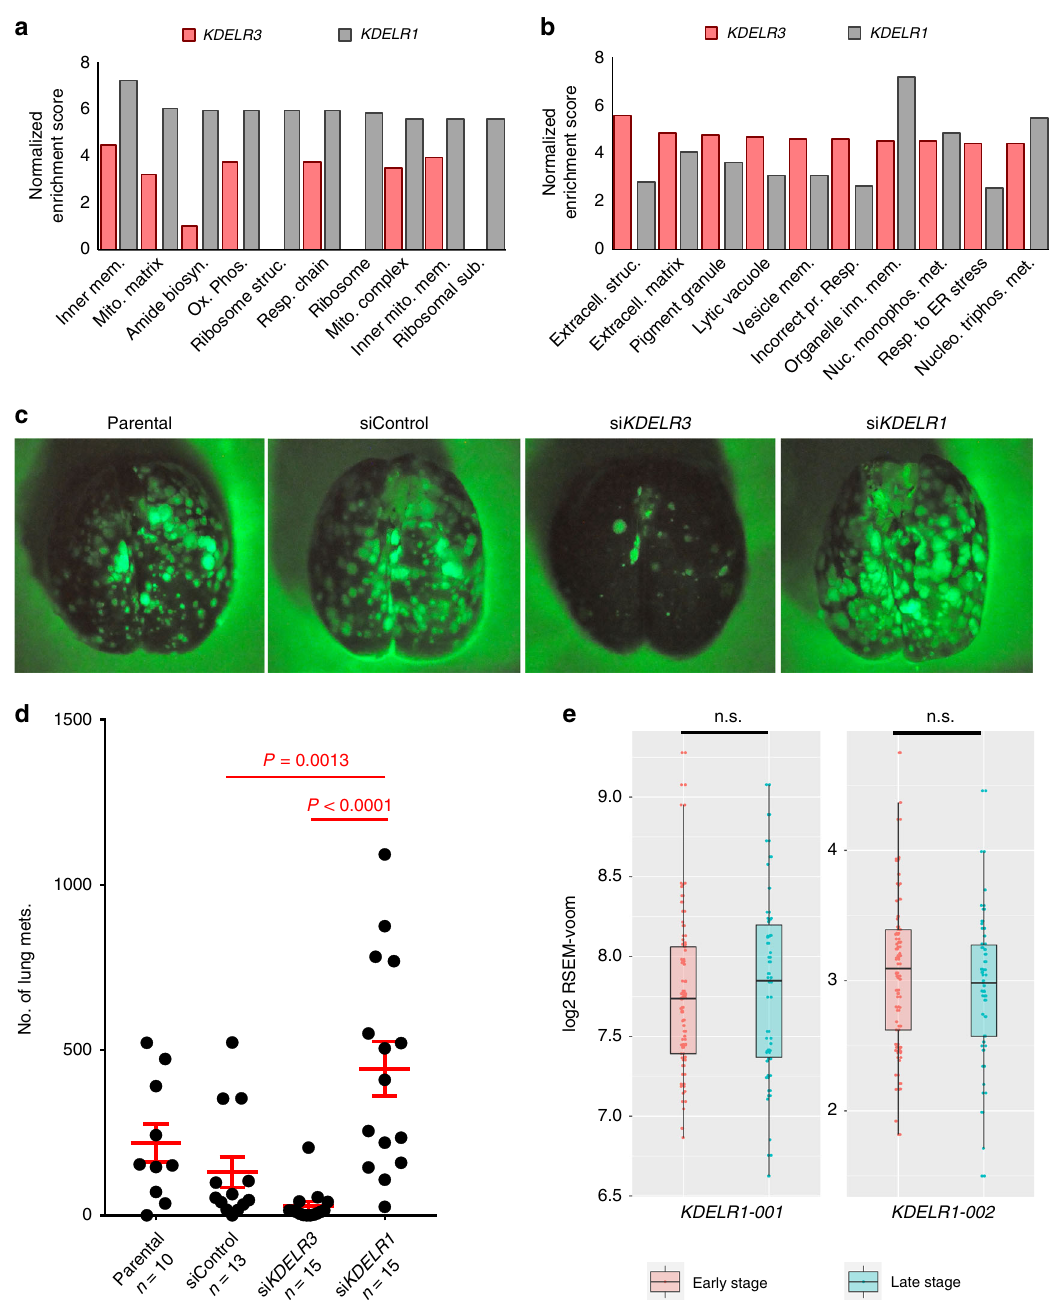
Fig. 7 KDELR1 knockdown increases lung colonization in tail vein metastasis assays. a GSEA of gene co-expression within skin cutaneous melanoma patients of the TCGA ( n = 479). Top 10 KDELR1 -associated GO pathways represented, FDR <0.0001. GO pathways in order: Organelle inner membrane; Mitochondrial matrix; Amide biosynthetic process; Oxidative phosphorylation; Structural constituent of ribosome; Respiratory chain; Ribosome; Mitochondrial protein complex; Inner mitochondrial membrane protein complex; Ribosomal subunit. b GSEA of gene co-expression within skin cutaneous melanoma patients of the TCGA ( n = 479). Top 10 KDELR3 -associated GO pathways represented, FDR <0.0001. GO pathways in order: Extracellular structure organization; Extracellular matrix; Pigment granule; Lytic vacuole; Vesicle membrane; Response to topologically incorrect protein; Organelle inner membrane; Nucleoside monophosphate metabolic process; Response to endoplasmic reticulum stress; Nucleoside triphosphate metabolic process. c , d Tail vein metastasis of KDELR1 siRNA-mediated knockdown ( N = 15) human 1205Lu cells transduced with Ferh-luc-GFP . Parental ( N = 10), siControl ( N = 13), and si KDELR3 ( N = 15) were used as controls. Images of whole mouse lung were taken at 1× magni fi cation. ANOVA with Tukey ’ s multiple comparison test; siControl vs. si KDELR1 , P = 0.0013 [mean difference (95% CI): − 312.5 ( − 521.7, − 103.4)]; si KDELR3 vs. si KDELR1 , P < 0.0001 [mean difference (95% CI): − 415.3 ( − 616.8, − 213.7)]. d.f. = 49, F = 10.8. CI, con fi dence interval of differences. Line and error bars represent mean ± s.e.m. e KDELR1-001 and KDELR1- 002 patient expression data. Empirical Bayes moderated t -statistic (unpaired two-tailed test); KDELR1-001 , ENST00000330720, P = 0.73, t = 0.35, d.f. = 102.17; KDELR1-002 , ENST00000597017, P = 0.39, t = − 0.86, d.f. = 102.17. Boxplots of patient expression data from TCGA-SKCM dataset, depicting the 25th, 50th (median), and 75th percentile, and extreme values of the transcript expression. “ Early ” stage (stages I/II, N = 62 patients). “ Late ” stage (stages III/IV, N = 39 patients). n.s., not signi fi